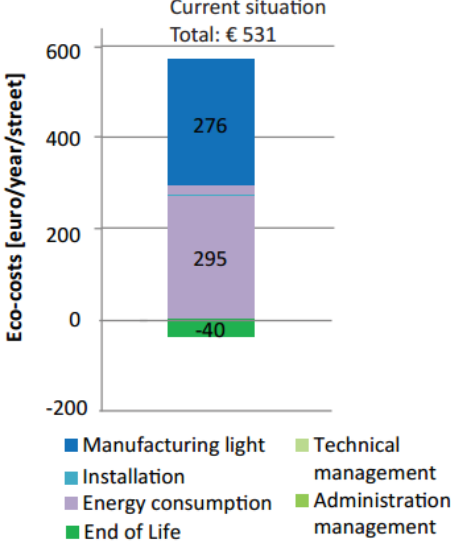
Figure 10. Eco-costs costs for lighting: one street for one year of the base case.